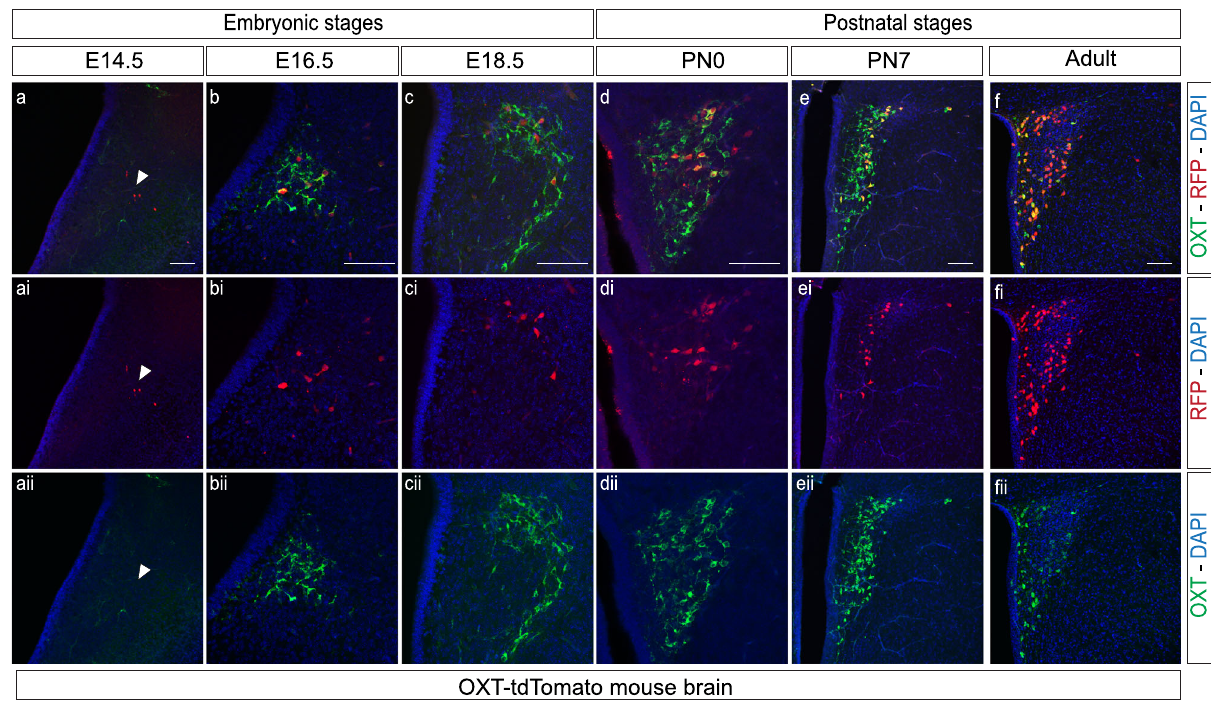
Fig. 8 Analysis of OXT expression in an OXT-tdTomato mouse line. Coronal sections of the PVN at a range of stages: E14.5 ( a – aii ), E16.5 ( b – bii ), E18.5 ( c – cii ), PN0 ( d – dii ), PN7 ( e – eii ) and adult ( f – fi i ). Immunohisto fl uorescence against anti-RFP (red) and anti-OXT (green). Scale bar: 50 µ m in a – d , 150 µ m in e , f .